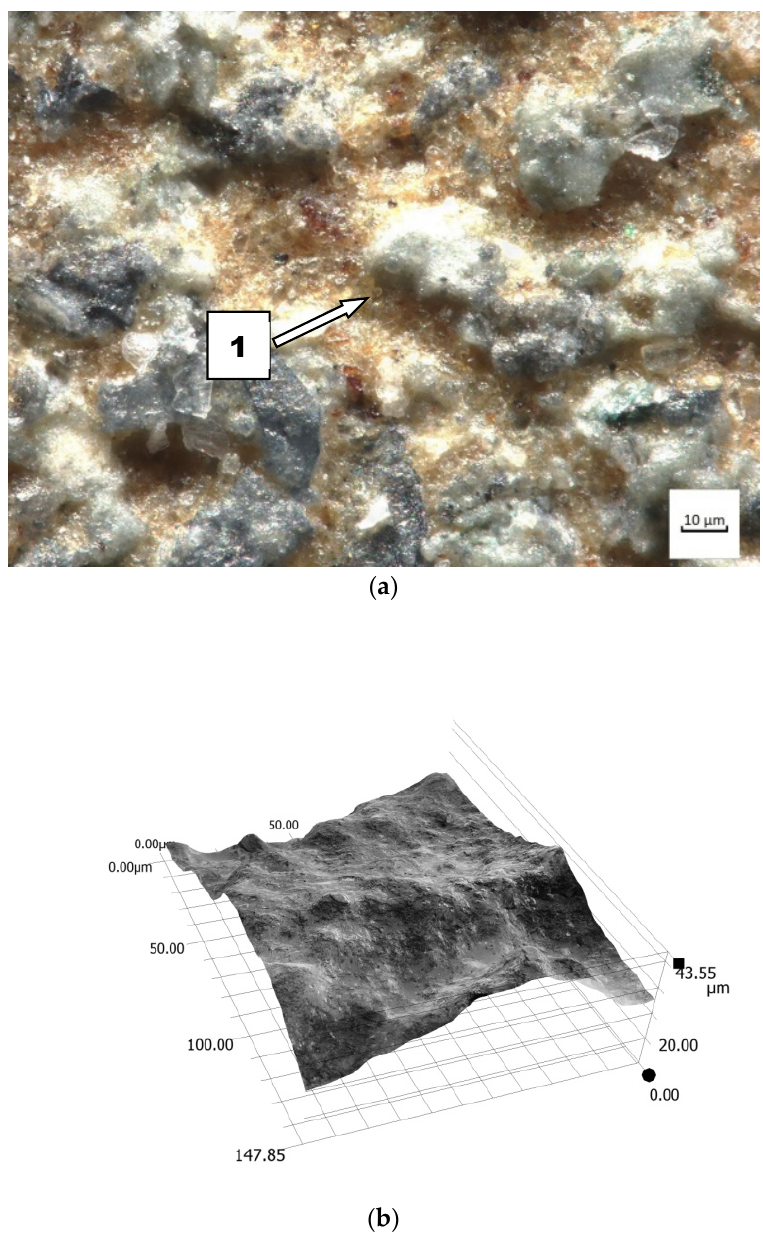
Figure 12. The friction surface condition after wear in medium soil: ( a ) view of coated grains of silicon carbide, magnitude 500 × , (1) carbide grains before removal; ( b ) friction surface profile.